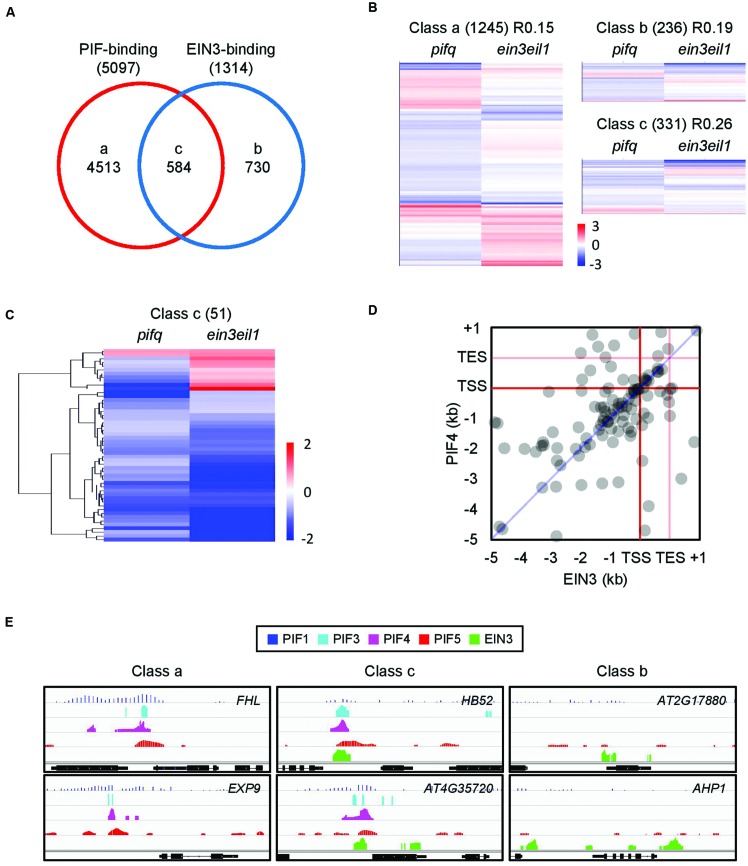
Phytochrome-interacting factors and EIN3 bind and regulate overlapping target genes. (A) PIF-binding and EIN3-binding genes significantly overlap. Data were retrieved from relevant ChIP-chip or ChIP-seq databases (Oh et al., 2009, 2012; Hornitschek et al., 2012; Chang et al., 2013; Zhang et al., 2013). Lowercase letters indicate PIF and/or EIN3 binding classes. (B) Hierarchical clustering of the expression patterns for each gene class from (A). Gene expression data were retrieved from previous pifq and ein3/eil1 microarrays (Shin et al., 2009; Zhong et al., 2009). Genes whose expression data correspond to P < 0.05 in at least one of the two microarrays are shown. (C) Hierarchical clustering of the expression patterns for class c genes. Fold changes were rescaled to ± 2 (Log2) and only genes whose expression data correspond to P < 0.05 in both microarrays are shown. Gene expression data were retrieved from the same source as (B). (D) Spatial distribution of PIF4- and EIN3-binding peaks along the promoter (-5 kb to start), coding (TSS, TES) and 3′ (TES to +1 kb) regions of shared target genes. Binding peak data were retrieved from published ChIP-seq experiments performed on PIF4 and EIN3 (Oh et al., 2012; Chang et al., 2013). The analysis was re-done as described in the section “Materials and Methods.”. (E) Representative PIF- and EIN3-binding peaks in the promoters of shared or non-shared target genes from the gene classes defined in (A).